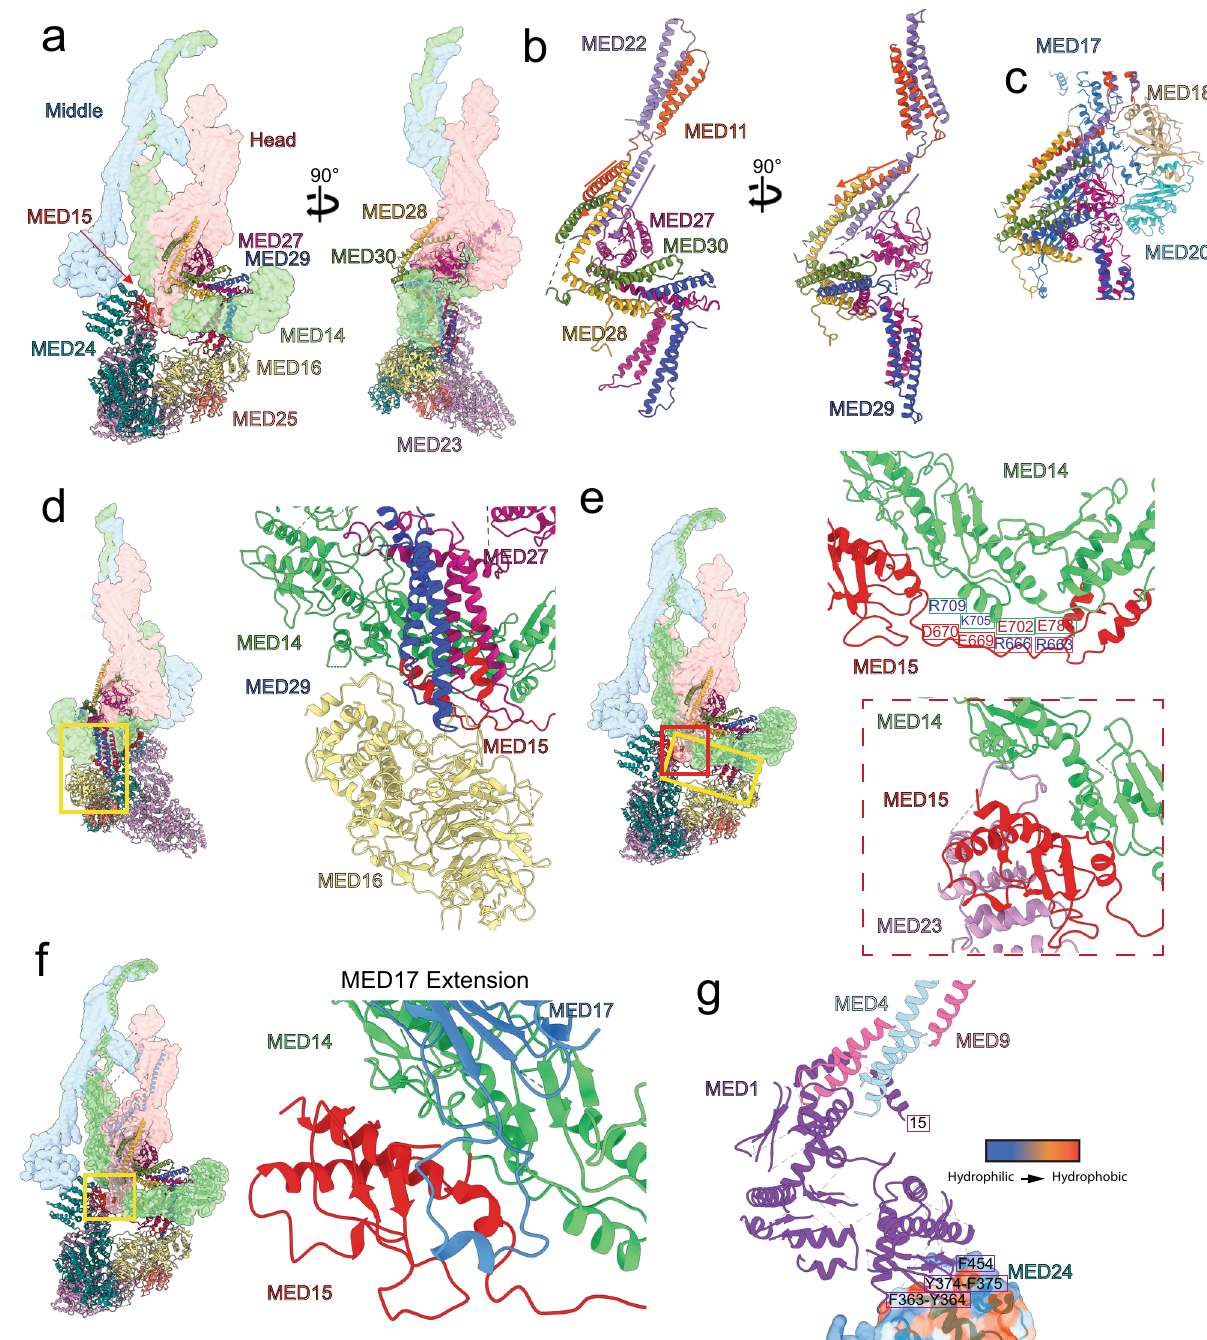
Fig. 6 Tail – core interactions. a Overall lower Tail structure and its interaction with core mMED (Head light red, MED14 light green, Middle light blue). b Interaction of MED28 – MED30 in the upper Tail with MED11 – MED22 in the Head. c Interaction of the upper Tail ’ s MED27 C-terminus with MED18 – MED20 and MED17 in the Head. d Interaction of the helical bundle formed by helices in MED27 – 29 (upper Tail) and MED15 (lower Tail) with MED14. e Charge interactions between an extended MED15 loop and the MED14 C-terminus (top), and interaction of a globular MED15 C-terminal domain (nestled between MED23 and MED24) with MED14 (bottom). f Details of interactions established by the MED15 C-terminal domain with MED14 and the MED17 C-terminal extension. g Interaction between MED1 N-terminal domain β -strands (aa ~437 – 481) rich in hydrophobic residues with a hydrophobic patch on the surface of the MED24